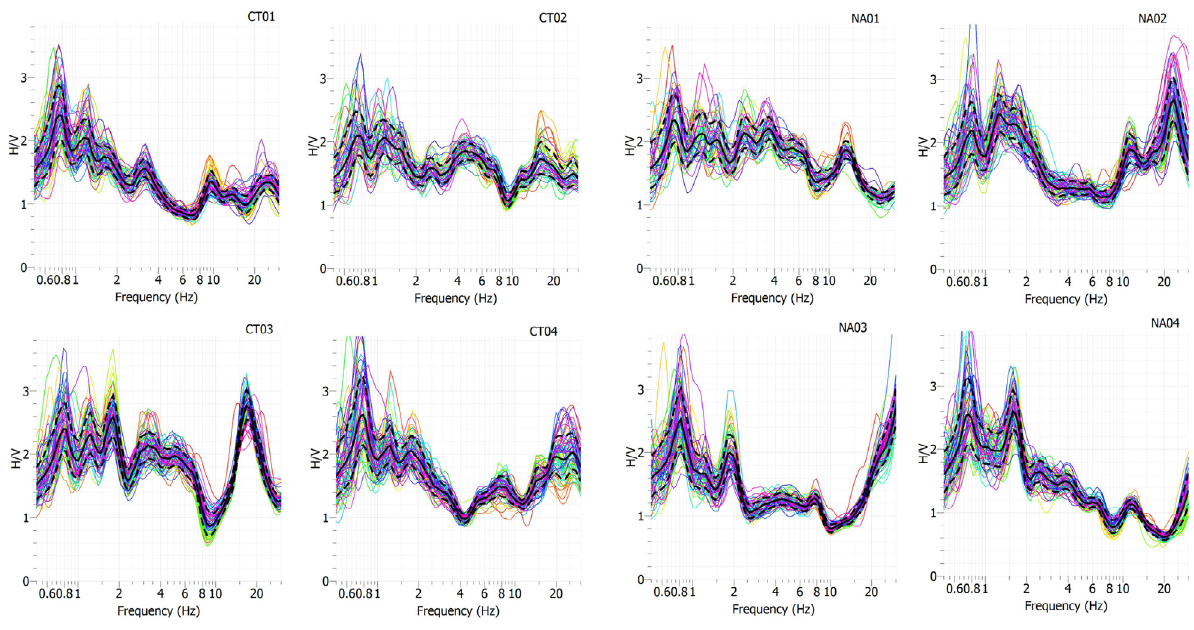
Figure 5. HVSR curve (horizontal-to-vertical spectral ratio). The black continuous curve represents H/V amplitude averaged over all coloured individual H/V curves, while the dashed black curves represent the H/V standard deviation. The coloured curves are the H/V functions of individual time